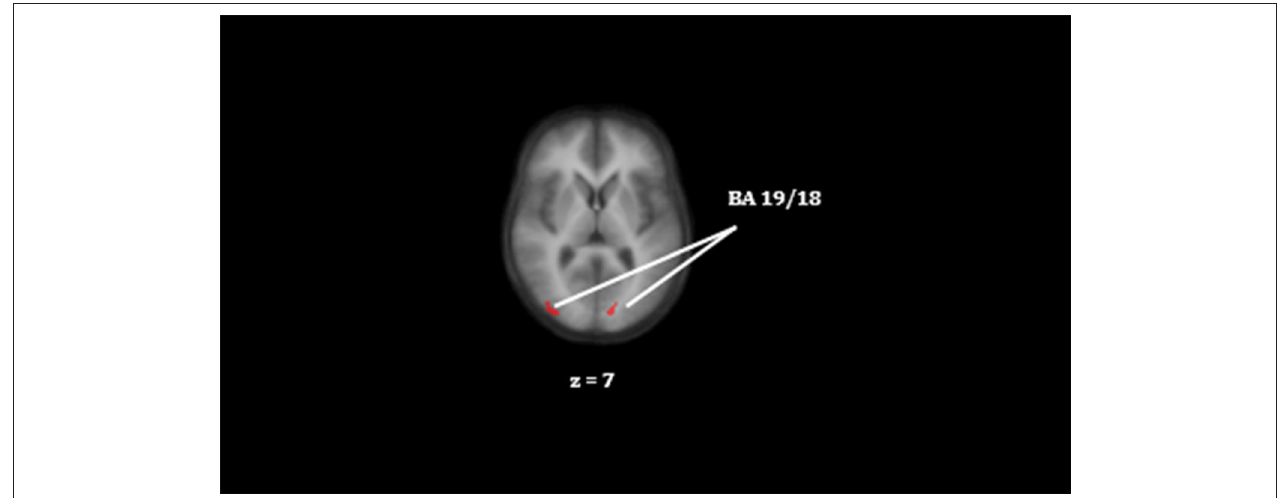
Table 3 . Clusters on an anatomical image averaged over all participants in the Talairach standard space, according to the radiological convention. BA indicate the Brodmann area.